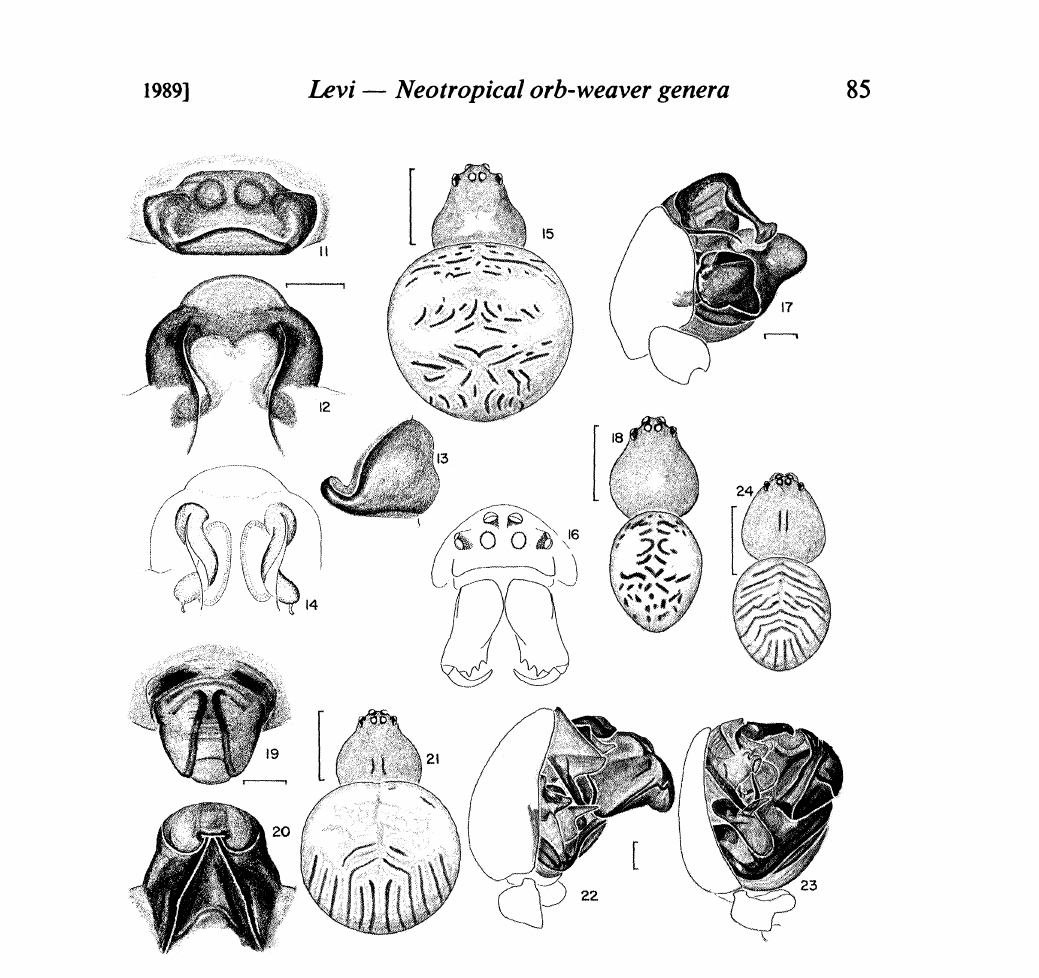
Figures 11-18. Bertrana striolata Keyserling. 11-16, female. 11, epigynum, ven- tral. 12, epigynum, posterior. 13, epigynum, lateral. 14, epigynum, posterior, cleared. 15, dorsal. 16, chelicerae and eye region. 17, 18, male. 17, left palpus. 18, dorsal. Figures 19-24. B. rufostriata Simon. 19-21, female. 19, epigynum, ventral. 20, epigynum, posterior. 21, dorsal. 22-24, male. 22, 23, palpus. 24, dorsal. Scale lines. 1.0 ram; genitalia 0.1 mm. 1.2, tarsus 0.4. Second patella and tibia 1.3 mm, third 0.8, fourth 1.2. Male from Panama: Color as in female (Fig. 18). Posterior median eyes diameter of anterior medians, anterior laterals 0.8 diameter, posterior laterals 0.8. Anterior median eyes 1.5